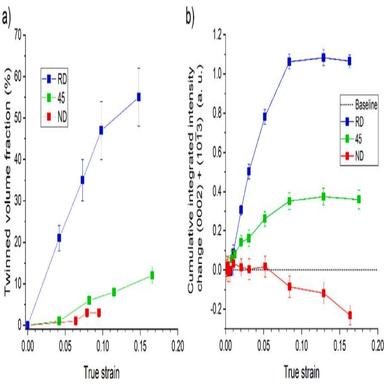
a) Result of the EBSD-based analysis of the twin volume fraction, b) cumulative integrated intensity changes of the (0002) and (10 1 3) diffraction peaks.